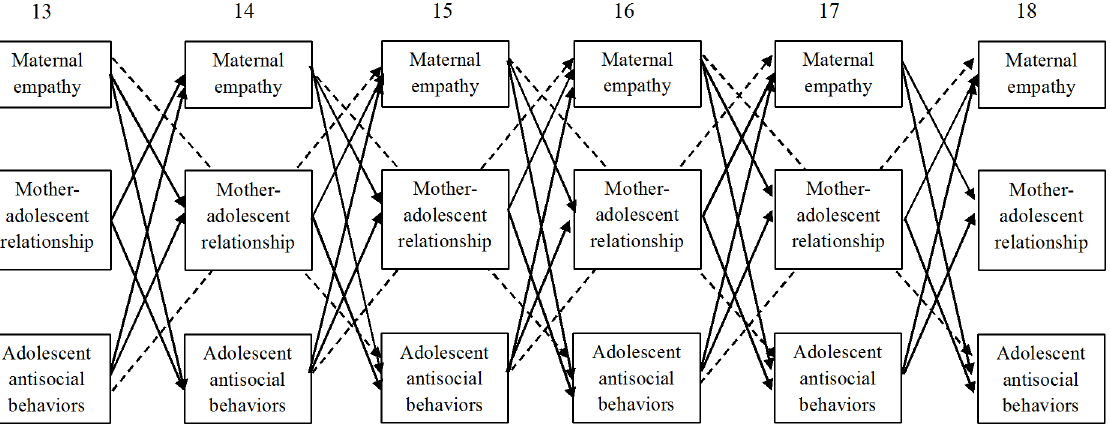
Fig 1. Schematization of the Tested Model. Continuous lines represent main effects and dashed lines represent indirect effects (i.e., effects of maternal empathy on antisocial behaviors mediated by mother-adolescent relationship quality; and effects of antisocial behaviors on maternal empathy mediated by mother-adolescent relationship quality). Stability paths and concurrent correlations were estimated but they are not reported in the figure for sake of clarity.